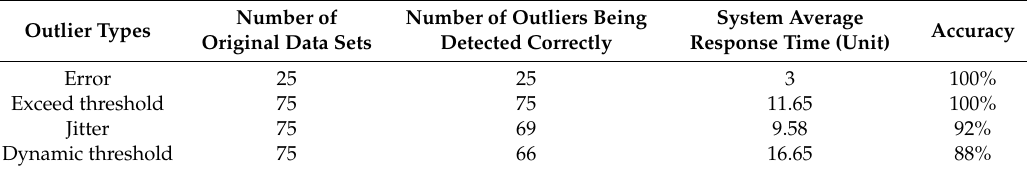
Table A2. Statistical outcomes of the experiment (sampling rate = 1 / 10 sec , network scale = 5000 nodes). Outlier Types